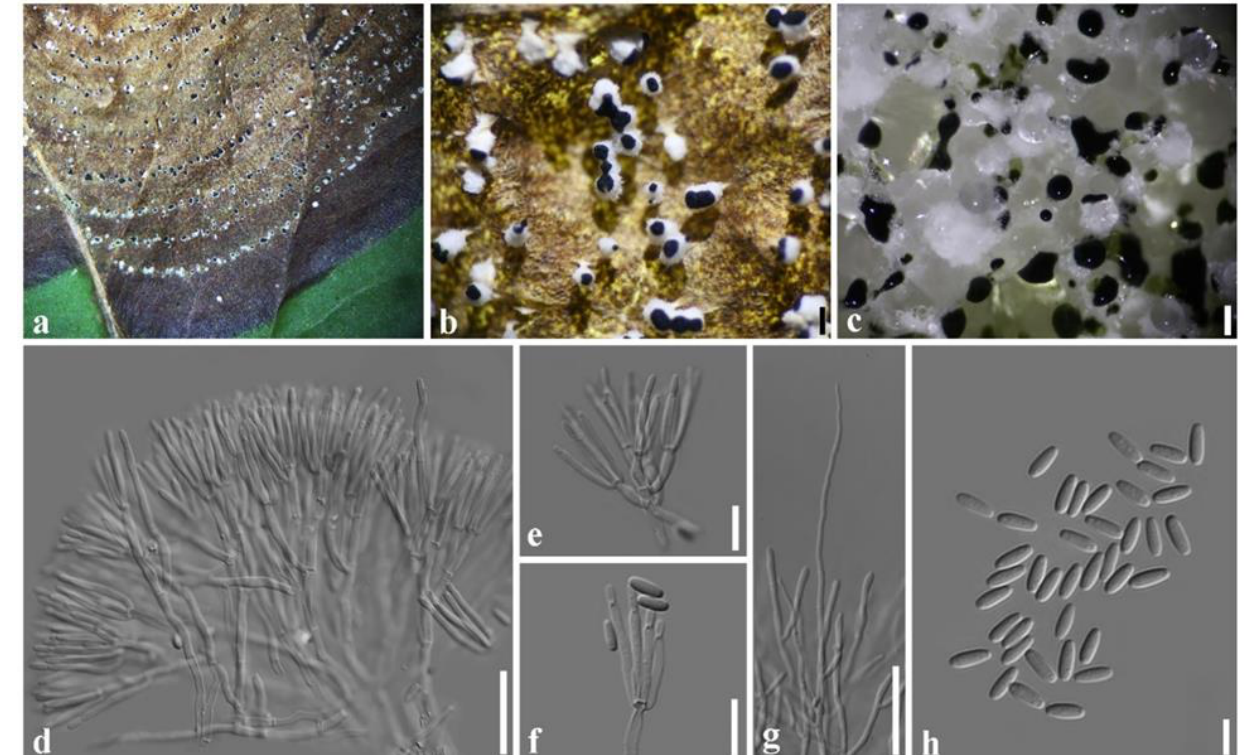
Figure 6. Paramyrothecium eichhorniae (CRC143); ( a ) leaf spot of Aristolochia sp.; ( b ) sporodochia on leaf; ( c ) sporodochial conidiomata on PDA; ( d ) sporodochia; ( e , f ) conidiogenous cells; ( g ) setae; ( h ) conidia. Scale bars: ( b , c ) = 1 mm; ( d , g ) = 20 µm; ( e , f ) = 10 µm; ( h ) = 5 µm. Culture characteristics: Colonies on PDA, entire to slightly undulated margins, with sporodochia forming on the surface of the medium, covered by slimy olivaceous green to black conidial masses.